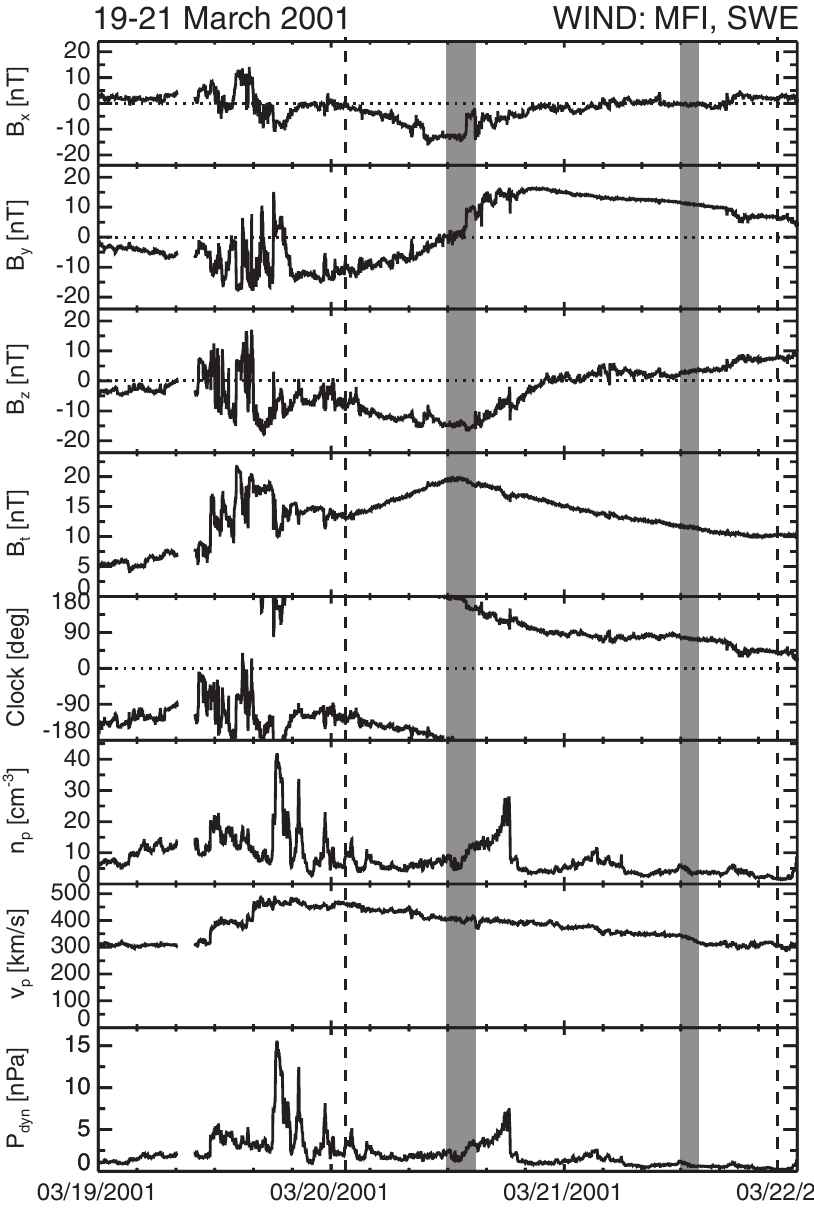
Fig. 4. Solar wind conditions for 19–21 March 2001 as observed by WIND. The interval of the study is marked by vertical dashed lines.